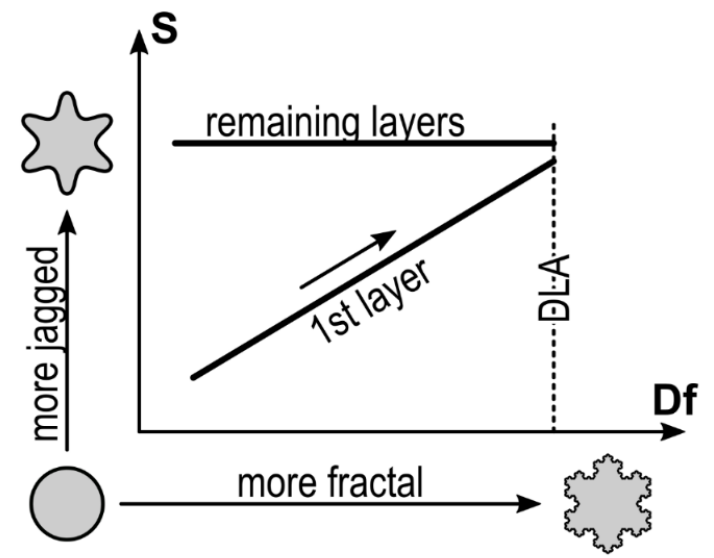
Figure 8. Qualitative interpretation of the geometric evolution of the island shape in terms of fractal dimension ( x -axis) and differential entropy ( y -axis) reported in Figure 7. The growth of the first (mono) layer is dictated by an initial formation of smooth circular islands, that progressively lose the circular symmetry and the contour becomes rougher ( S increases due to a more jagged contour). The initial compact shape of the islands in the next MLs (remaining layers) is driven by the underneath 6T ML, that promotes a dendritic/fractal shape so that the initial circular symmetry is never recovered.